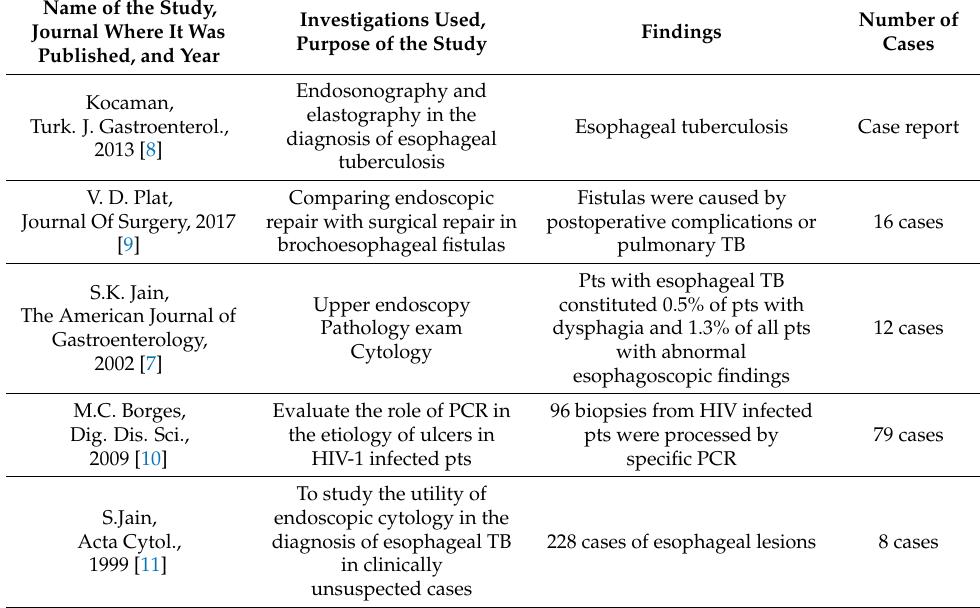
Table 2. Oesophageal tuberculosis and a comparison between the findings from different studies.